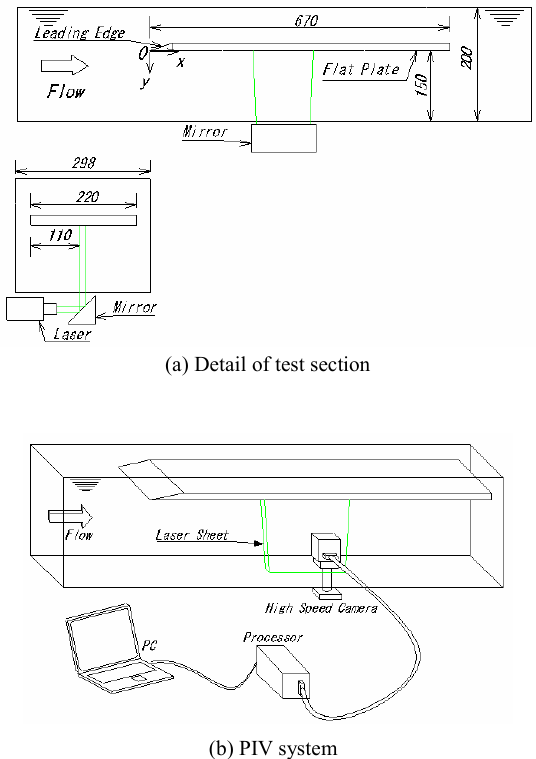
Fig. 1 Experimental apparatus (Unit: